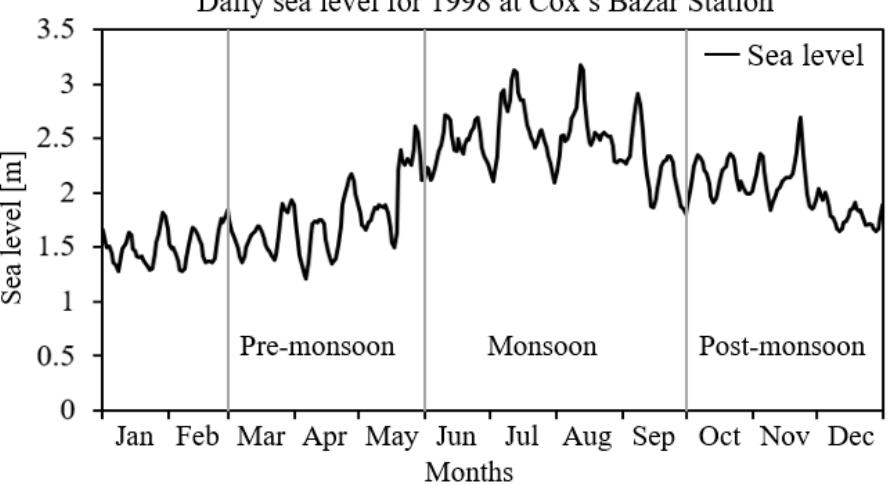
Figure A1. Time series for the seasonal variation of sea levels in 1998 at Cox’s Bazar Station. The sea level is varied by the seasonal effects of the pre-monsoon (March – May), monsoon (June – September), and post-monsoon (October – December).